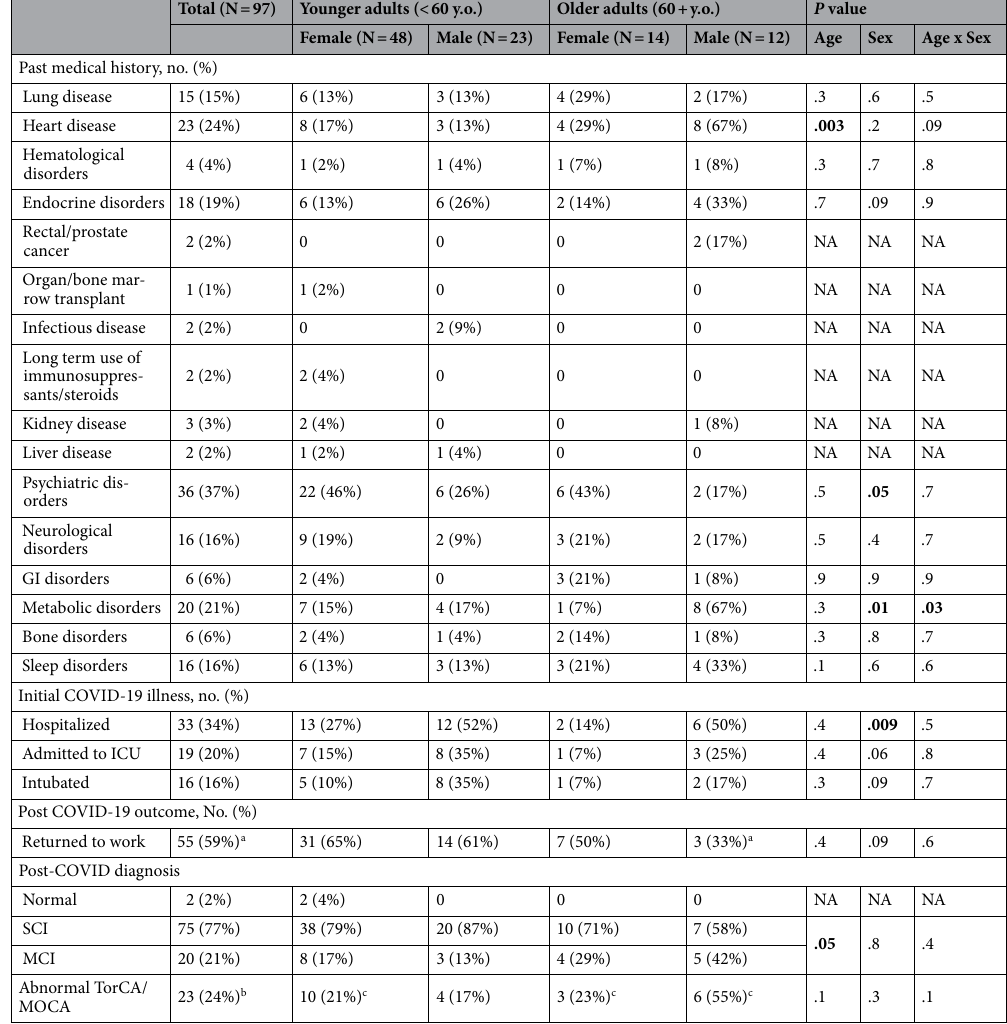
Table 1. Past medical history and COVID-19 acute illness outcomes stratified by age and sex. Data is presented as No. (%). Binary logistic regression was used; COVID-19 outcome analysis was adjusted for combined past medical history. “NA” designation was used where low per-group patient number did not allow for statistical comparisons. NA not applicable; SCI subjective cognitive impairment; MCI mild cognitive impairment; TorCA toronto cognitive assessment; MOCA montreal cognitive assessment. a Three patients were retired and were not included in this calculation. b Calculated out of total N = 94 patients that completed TorCA or MOCA assessment. c One patient did not complete TorCA or MOCA. Significant values are in